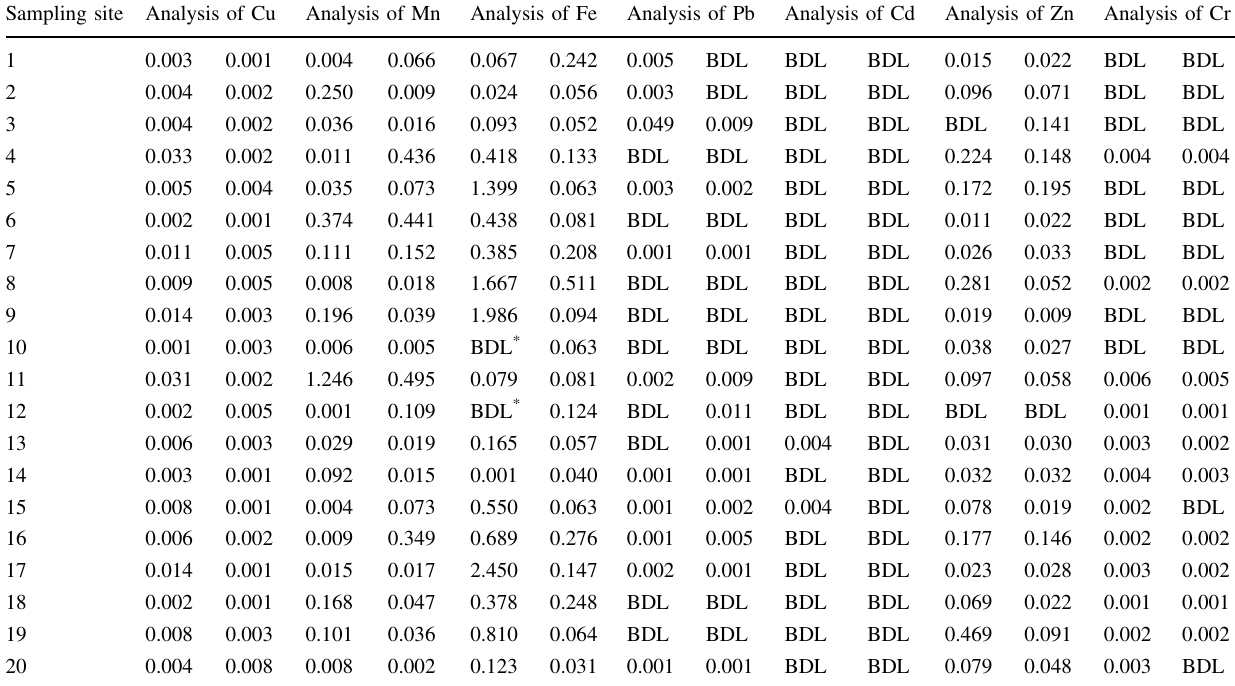
Table 2 Analysis of heavy metals concentration (ppm) in ground water (in mg/l) Sampling site Analysis of